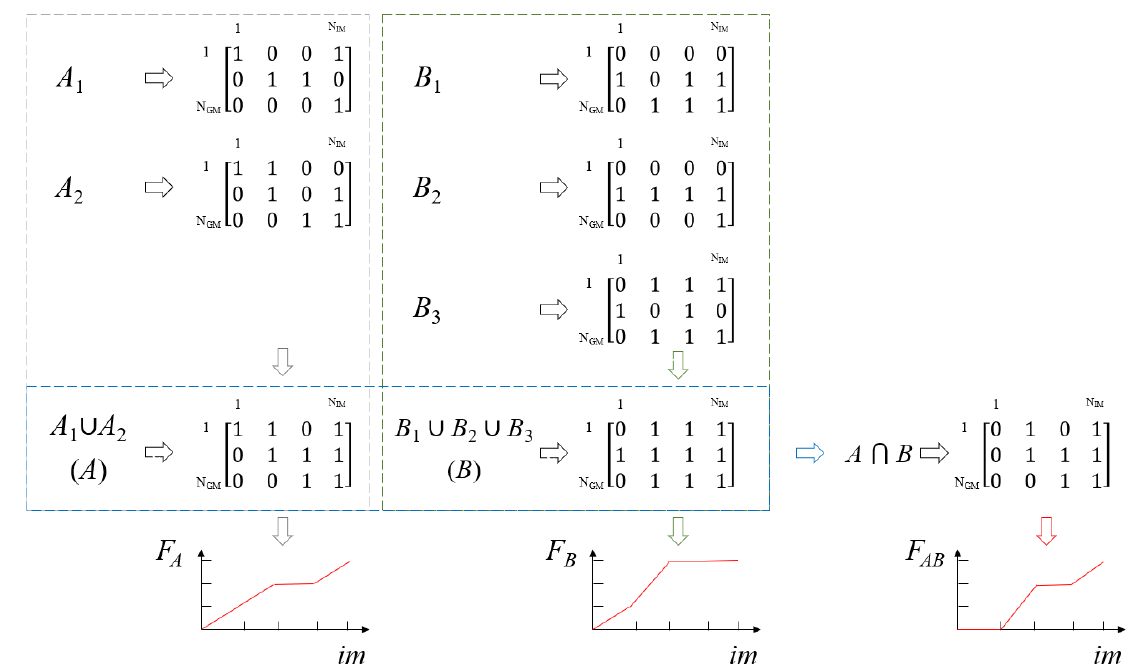
Figure 3. Flowchart for the multiple damage fragility functions estimation.